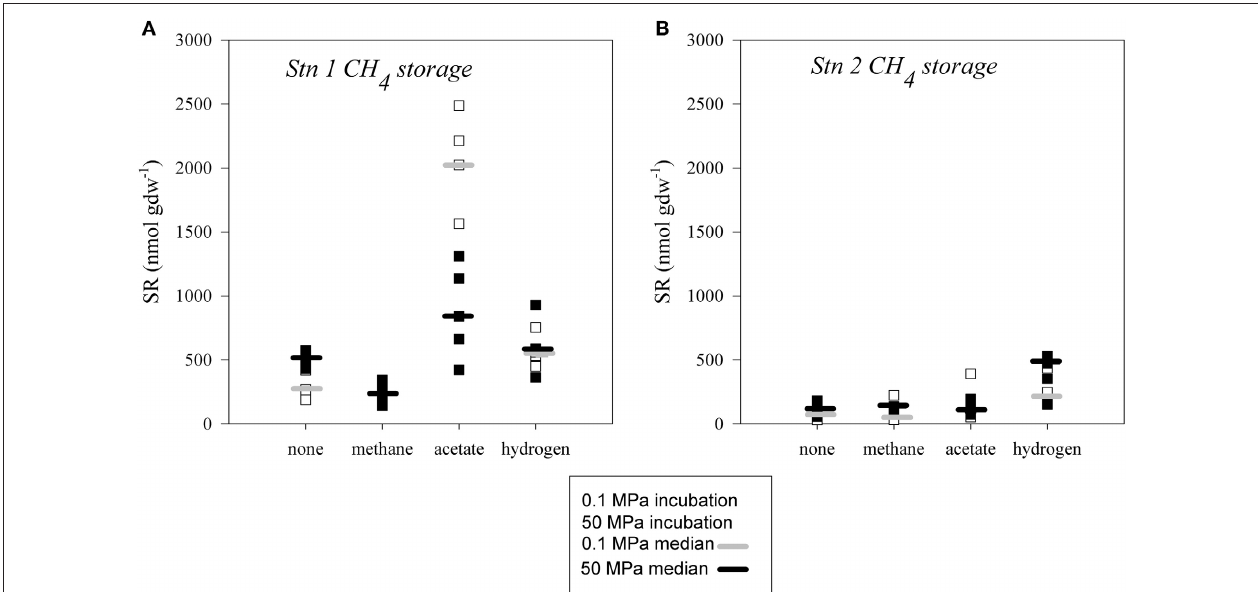
FIGURE 6 | Extents of sulfate reduction in sediment slurries stored with a methane partial pressure of 0.2MPa at (A) Station 1 and (B) Station 2. Incubations were conducted at atmospheric pressure (hollow square, median